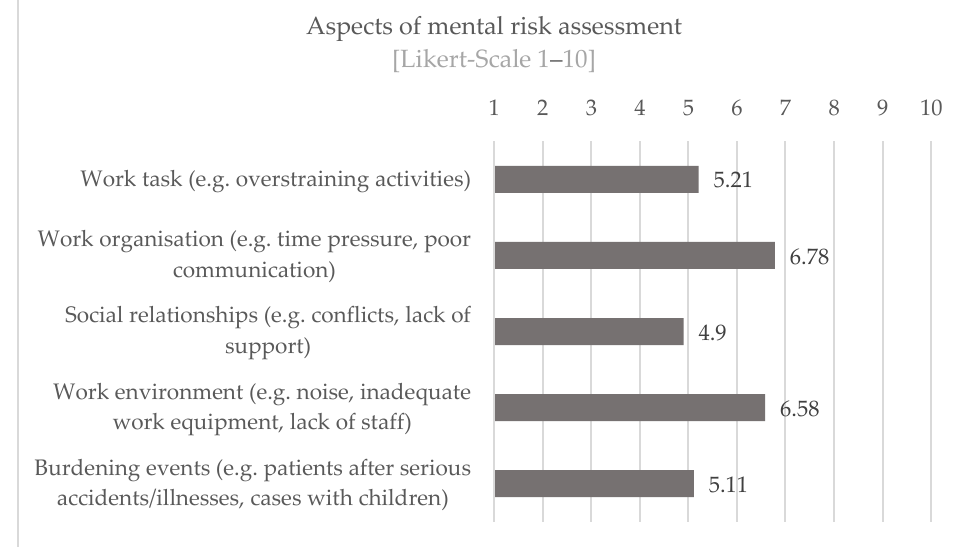
Figure 7. Assessment of workload through aspects of mental risk assessment.